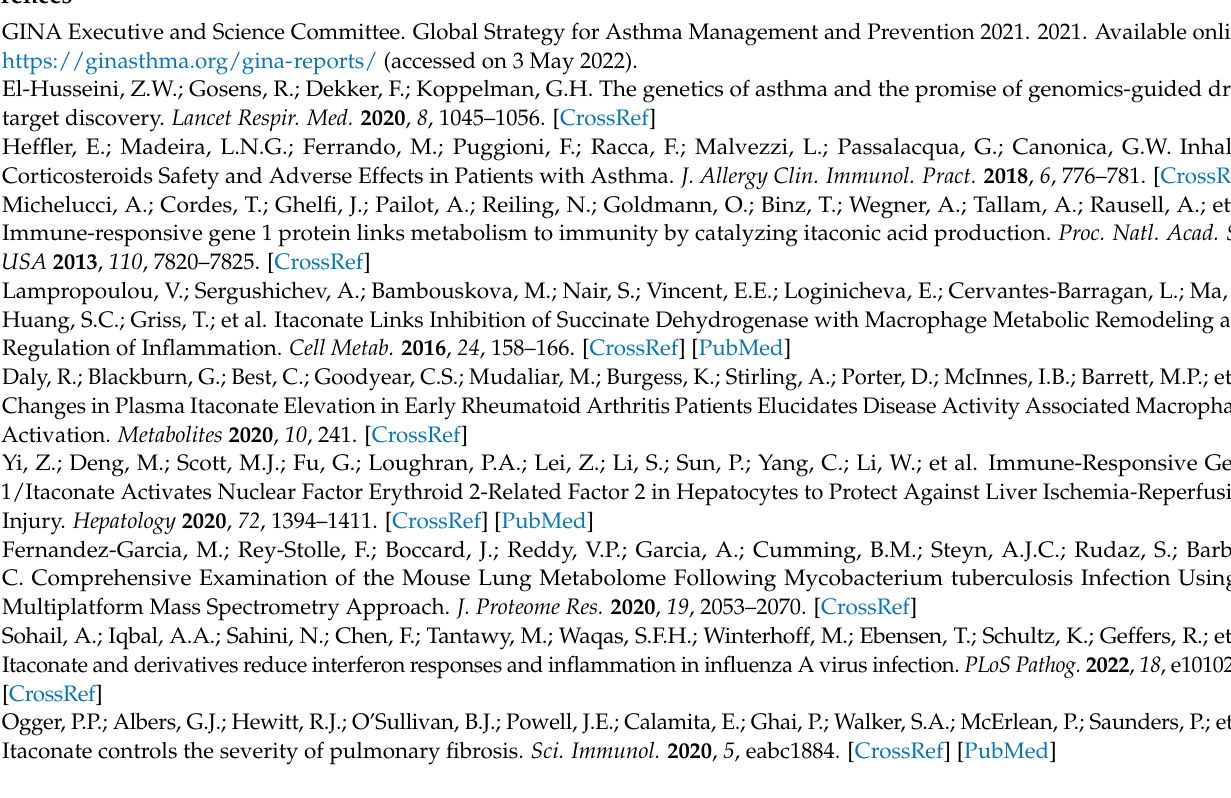
blots of Figure 1E; Figure S2. Raw blots of Figure 1L; Figure S3. Raw blots of Figure 2G; Figure S4. Raw blots of Figure 3C; Figure S5. Raw blots of Figure 3I; Figure S6. Raw blots of Figure 4A; Figure S7. Raw blots of Figure 4D; Figure S8. Raw blots of Figure 4G; Figure S9. Raw blots of Figure 4I; Figure S10. Raw blots of Figure 4K; Figure S11. Raw blots of Figure 4L; Figure S12. Raw blots of Figure 4N; Figure S13. Raw blots of Figure 6C; Figure S14. Raw blots of Figure 6D; Figure S15. Raw blots of Figure 6E; Figure S16. Raw blots of Figure 6F; Figure S17. Raw blots of Figure 6G; Figure S18. Raw blots of Figure 6H; Figure S19. Raw blots of Figure 6I; Figure S20. Additional bands used for statistics in Figure 6D; Figure S21. Additional bands used for statistics in Figure 6E; Figure S22. Additional bands used for statistics in Figure 6F; Figure S23. Additional bands used for statistics in Figure 6G–I; Figure S24. Raw blots of Figure S5G; Figure S25. Raw blots of Figure S6A; Figure S26. Raw blots of Figure S6E; Figure S27. Raw blots of Figure